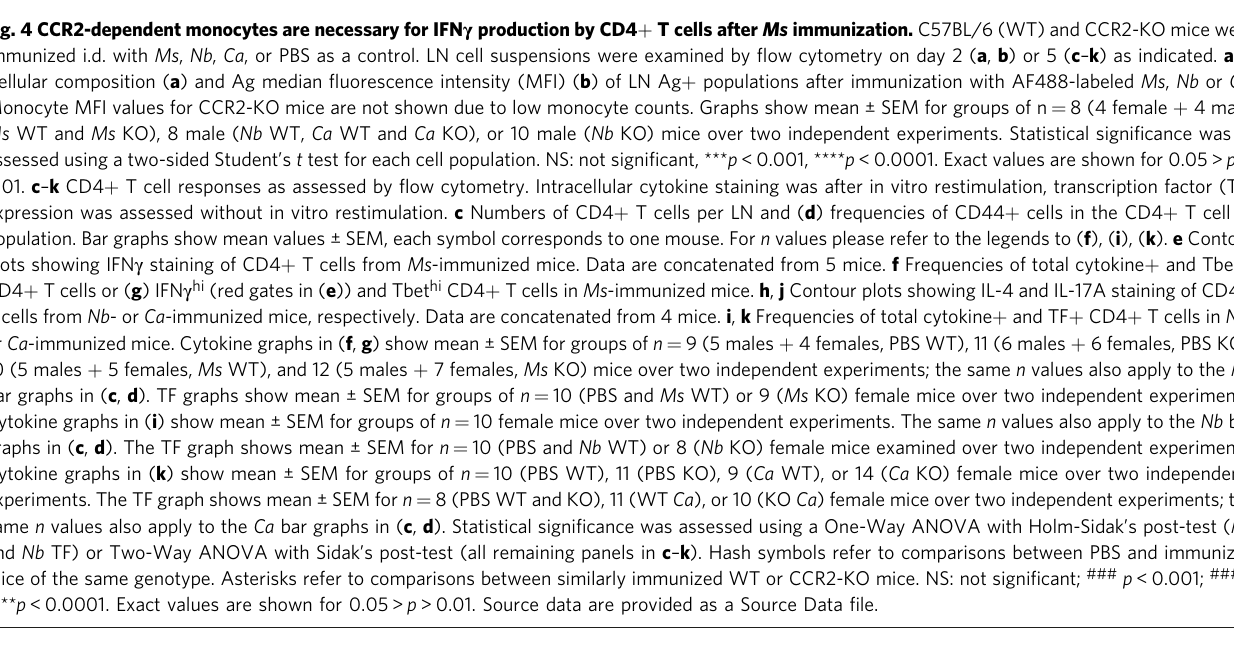
Fig. 4 CCR2-dependent monocytes are necessary for IFN γ production by CD4 + T cells after Ms immunization. C57BL/6 (WT) and CCR2-KO mice were immunized i.d. with Ms , Nb , Ca , or PBS as a control. LN cell suspensions were examined by fl ow cytometry on day 2 ( a , b ) or 5 ( c – k ) as indicated. a , b Cellular composition ( a ) and Ag median fl uorescence intensity (MFI) ( b ) of LN Ag + populations after immunization with AF488-labeled Ms , Nb or Ca